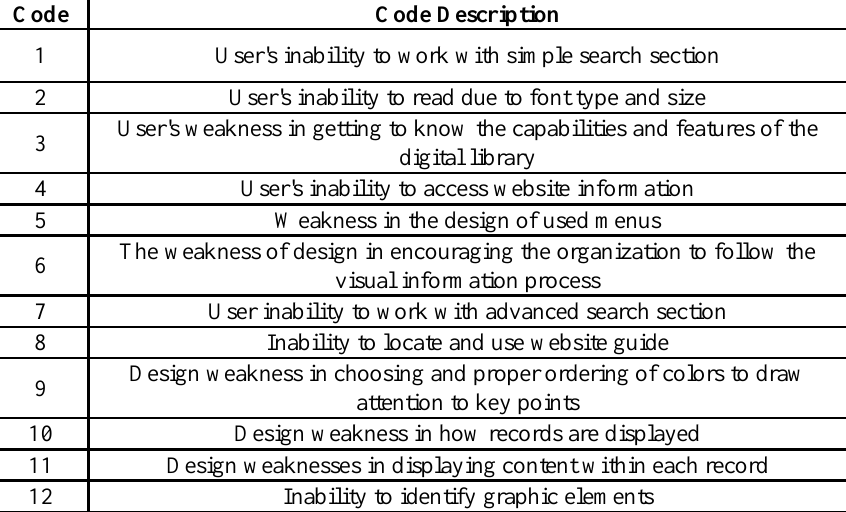
Table 2. Coding user experience in digital library of Allameh